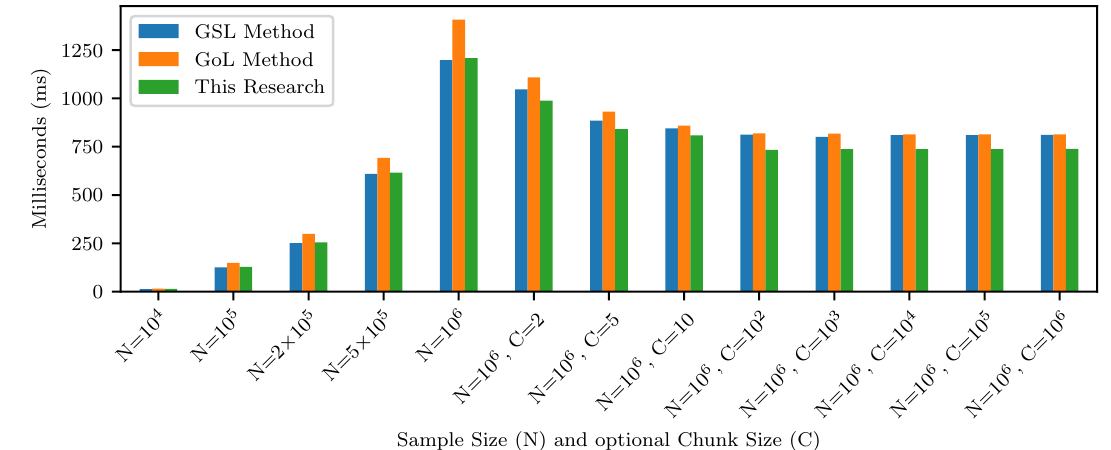
Figure 1. CSS algorithm performance comparison among the GSL method, the GoL method, and this research’s method with respect to different